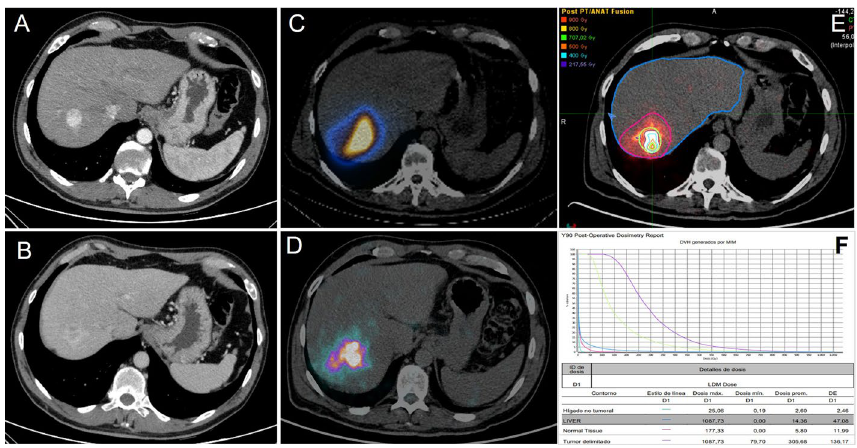
Fig. 4 Diagnostic CT in arterial ( A ) and portal ( B ) phases, showing a 23-mm hypervascular nodule in segment VII with contrast washout, diagnosis of HCC. Tc-99 m MAA SPECT/CT ( C ) and Y-90-PET/CT ( D ) image after administration of 0.78 GBq of glass microspheres, showing selective deposition of radioparticles on the tumor and, to a lesser extent, on the rest of the segment. Dosimetric study ( E and F ) using MIM software,